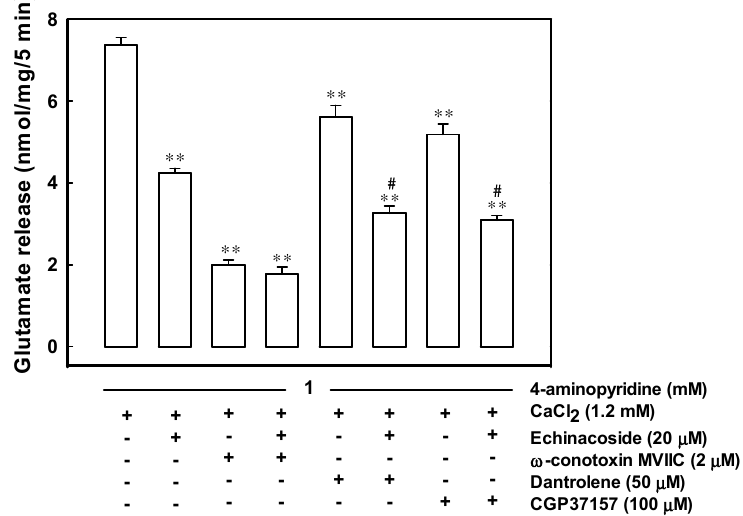
Figure 2. Effects of ω -conotoxin MVIIC, dantrolene, and 7-chloro-5-(2-chloropheny)-1,5- dihydro-4,1-benzothiazepin-2(3H)-one (CGP37157) on the echinacoside-mediated inhibition of 4-aminopyridine-evoked glutamate release. Glutamate release was evoked by 1 mM 4-aminopyridine